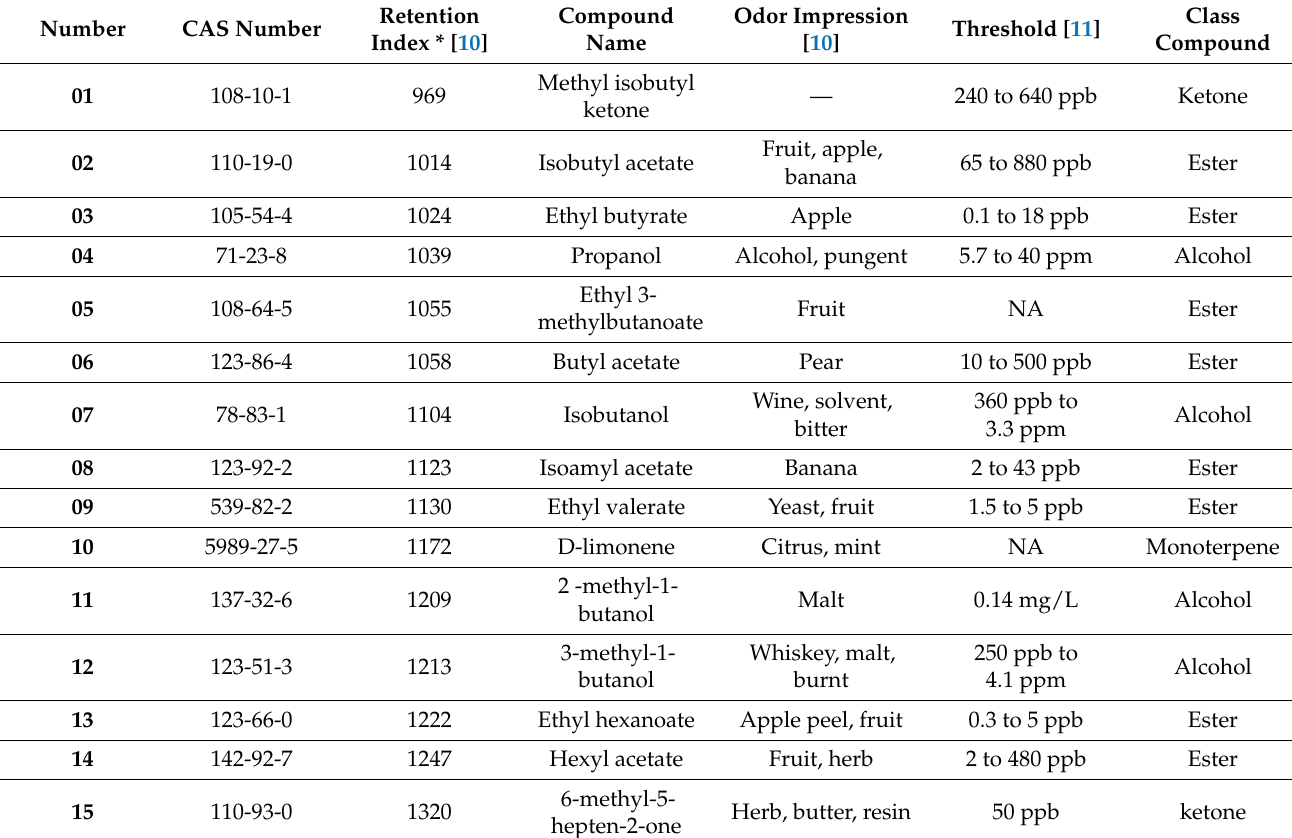
Table 1. GC-MS Compound identification during beer ageing under optimal storage